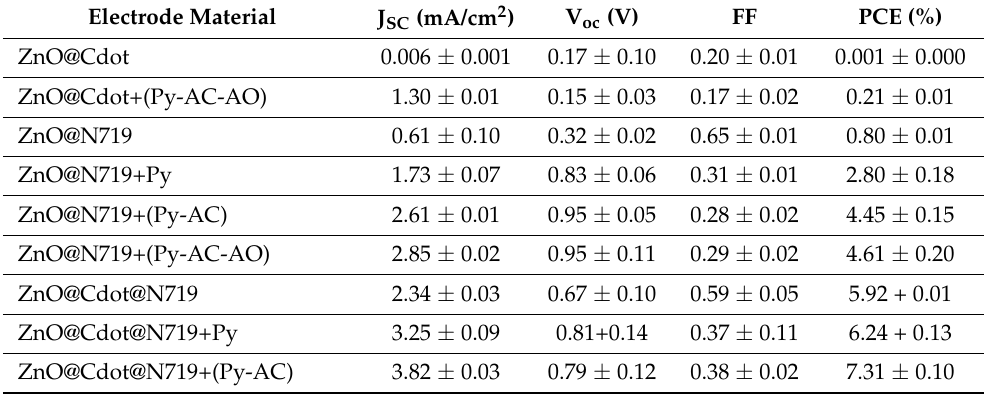
Table 1. Photovoltaic parameters of cascade FRET DSSCs.